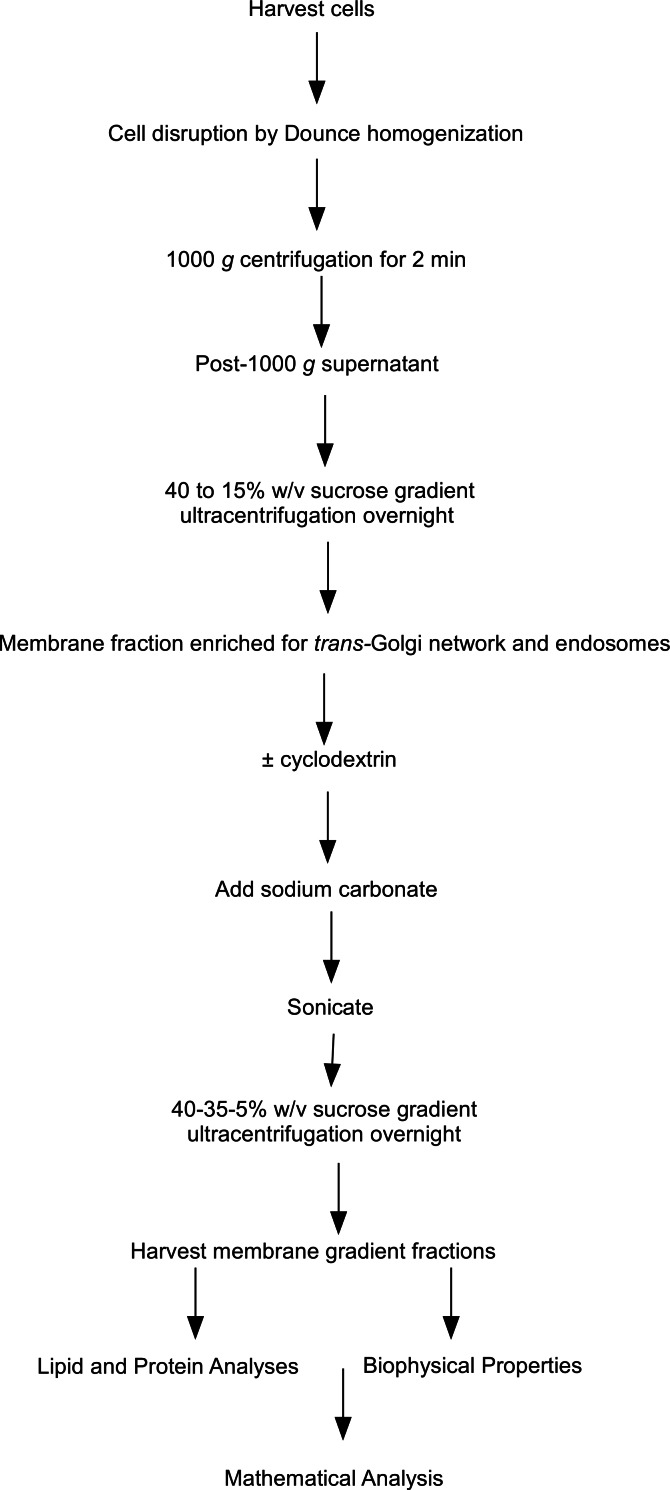
Flow chart of steps involved in the subcellular fractionation procedures.Flow chart outlining the steps involved in the subcellular fractionation procedures, equilibrium density floatation assay and membrane analyses used in the experiments.